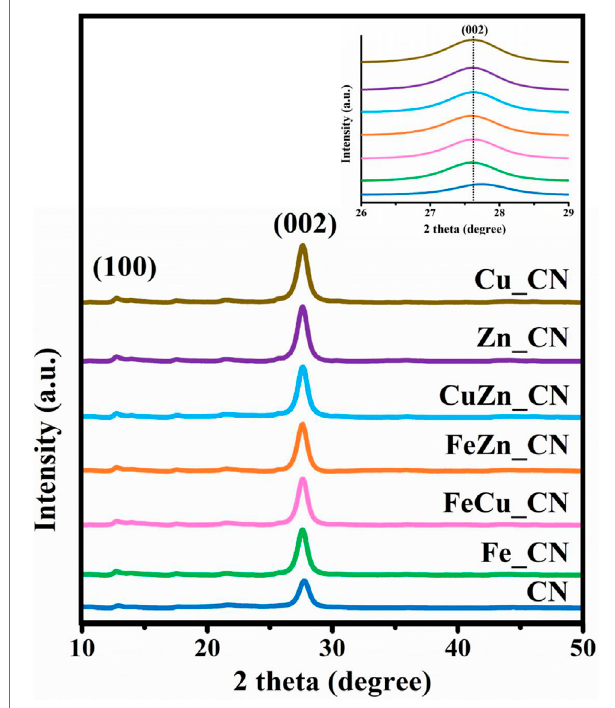
FIGURE 2 | EDX mapping for bi-metallic doping systems (A) FeCu_CN, (B) FeZn_CN, and (C) CuZn_CN.